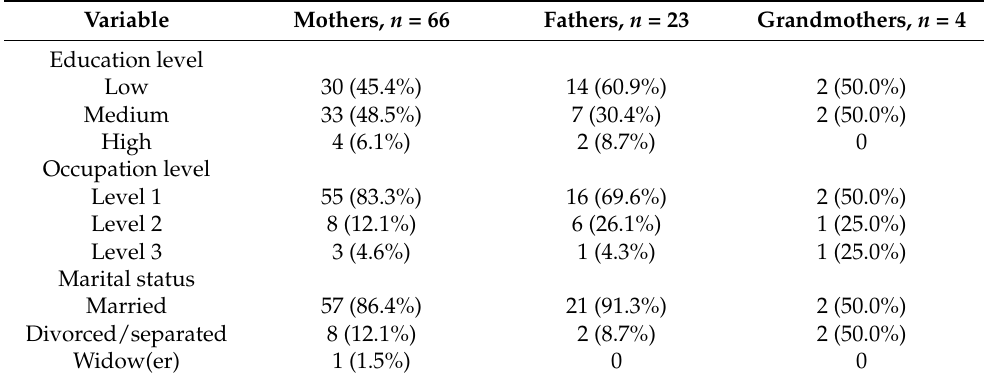
Table 2. Social status of caregivers.